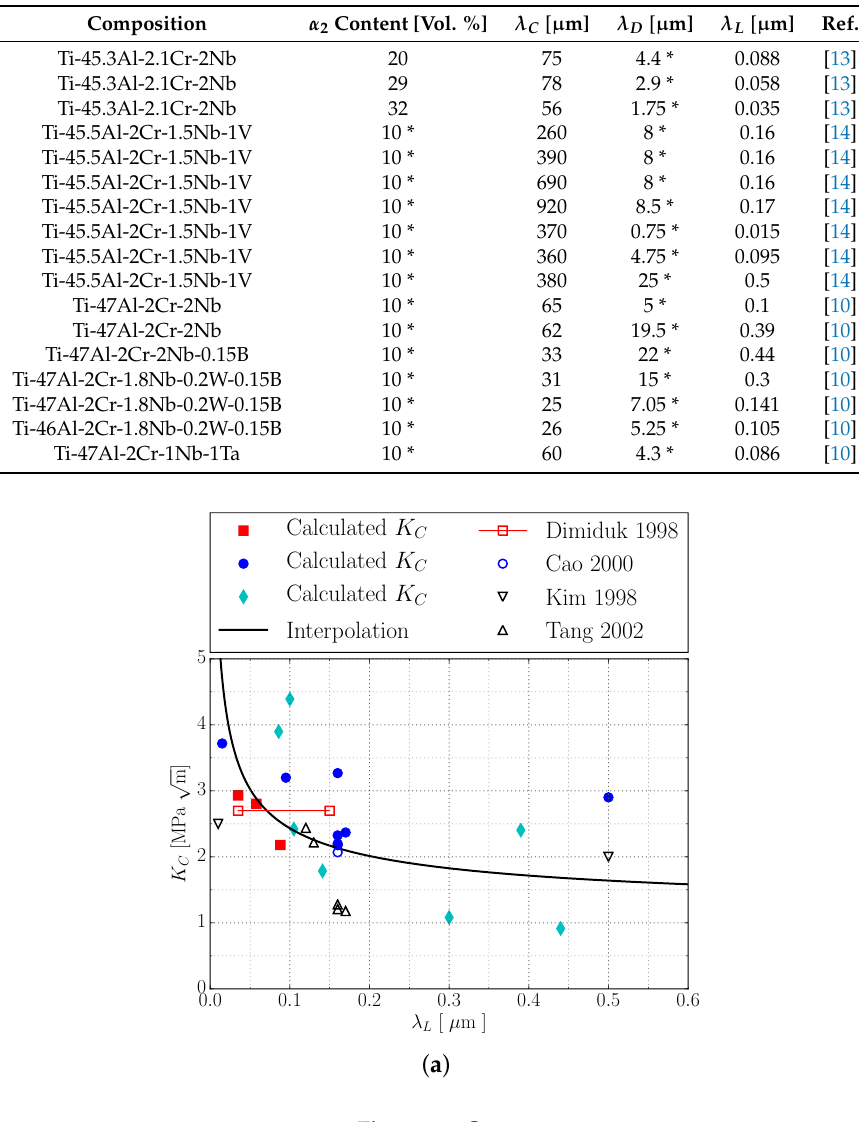
Table 4. Microstructural data from literature experiments with fully lamellar alloys. *: not reported. If no α 2 was reported in corresponding reference, it was set to 10 Vol. %; the domain sizes λ D are assumed to be 50 λ L Composition α 2 Content [Vol. %] λ C [ µ m] λ D [ µ m] λ L [ µ m] Ref.